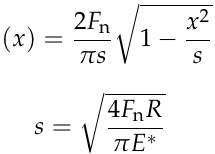
Table 1. The Young’s modulus and Poisson’s ratio in the subsequent calculations in this paper can be obtained by interpolating the data in Table 1.